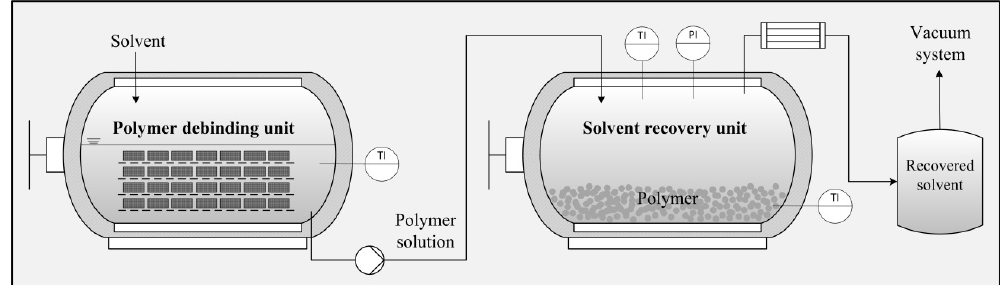
Figure 2. Process flow diagram of the technical ‐ scale application.